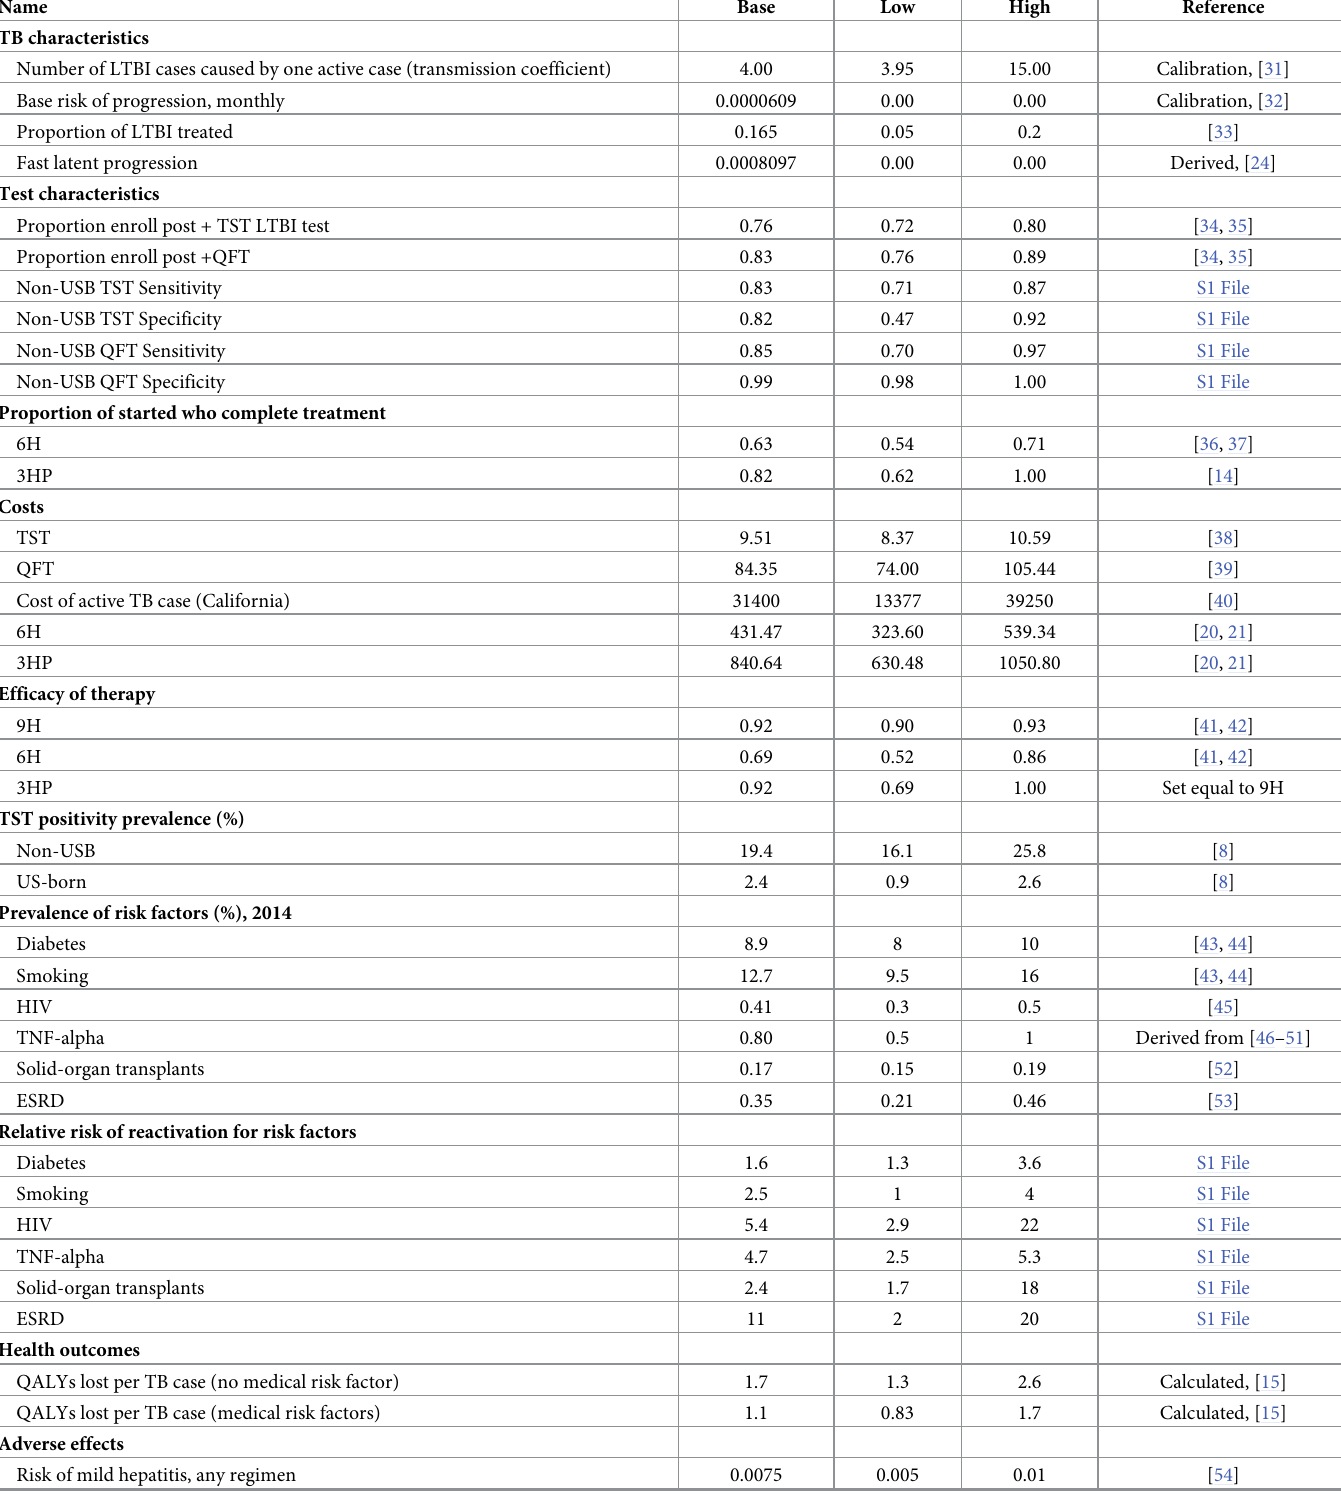
Table 1. Estimated values for single input